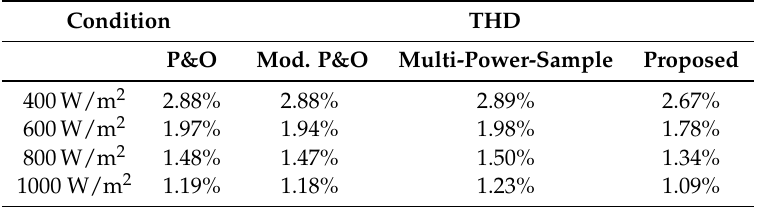
Figure 14. Grid-connected inverter behavior at various step changes of radiation (from top): Active power injected into the grid, reactive power, d -axis current, q -axis current, and the abc currents for: ( a ) P&O method; ( b ) modified P&O; ( c ) multi-power-sample method; ( d ) the proposed model-based technique. Table 2. THD performances of the abc currents with P&O, modified P&O, multi-power-sample, and the proposed